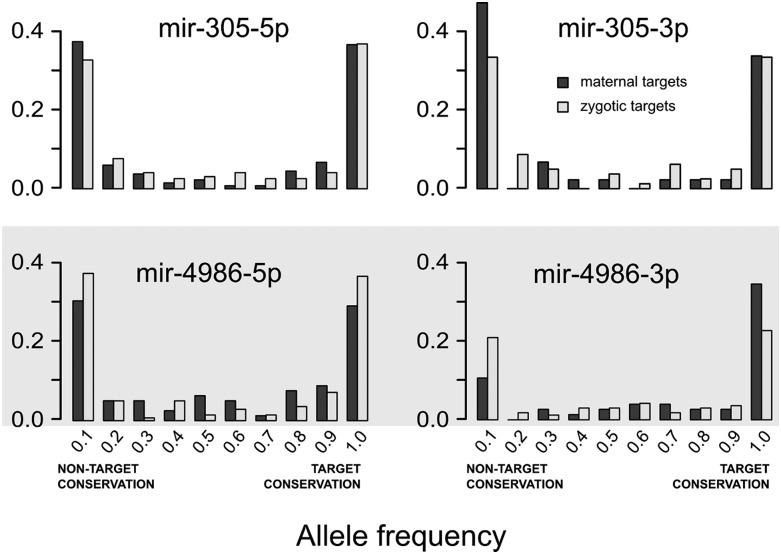
Allele frequency distribution for target sites of maternal microRNAs. Distribution of targets for maternal and zygotic transcripts for mir-305 (both arms are highly present in the egg) and mir-4986 (gray box, neither of the arms was detected in the egg).